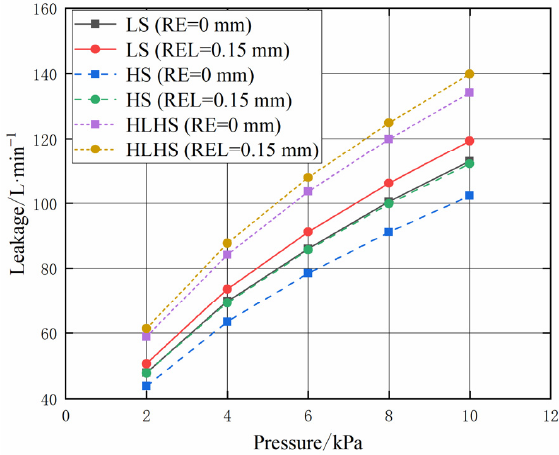
Figure 8. Leakage of three types of seals under different radial eccentricities.